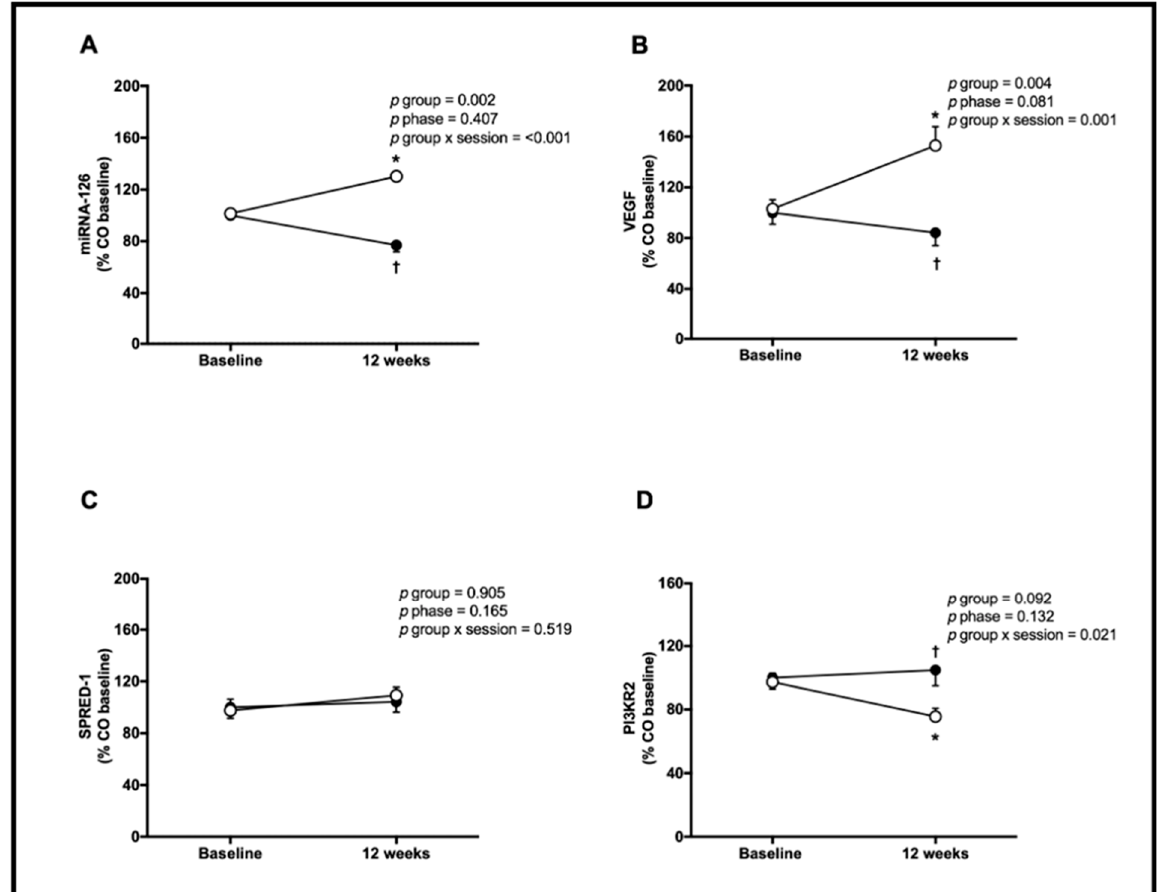
Figure 3. Muscle expression of microRNA-126 (miRNA-126, ( A )), vascular endothelial growth factor (VEGF, ( B )); sprouty-related protein 1 (SPRED-1, ( C )) and phosphoinositol-3 kinase regulatory subunit 2 (PI3KR2, ( D) ) assessed at baseline and after 12 weeks for the control (CO; n = 16, black circles) and walking training (WT; n = 16, white circles) groups. Data: mean ± SE. * denotes a difference from baseline within the group ( p < 0.05). † denotes a difference from WT at 12 weeks ( p < 0.05).